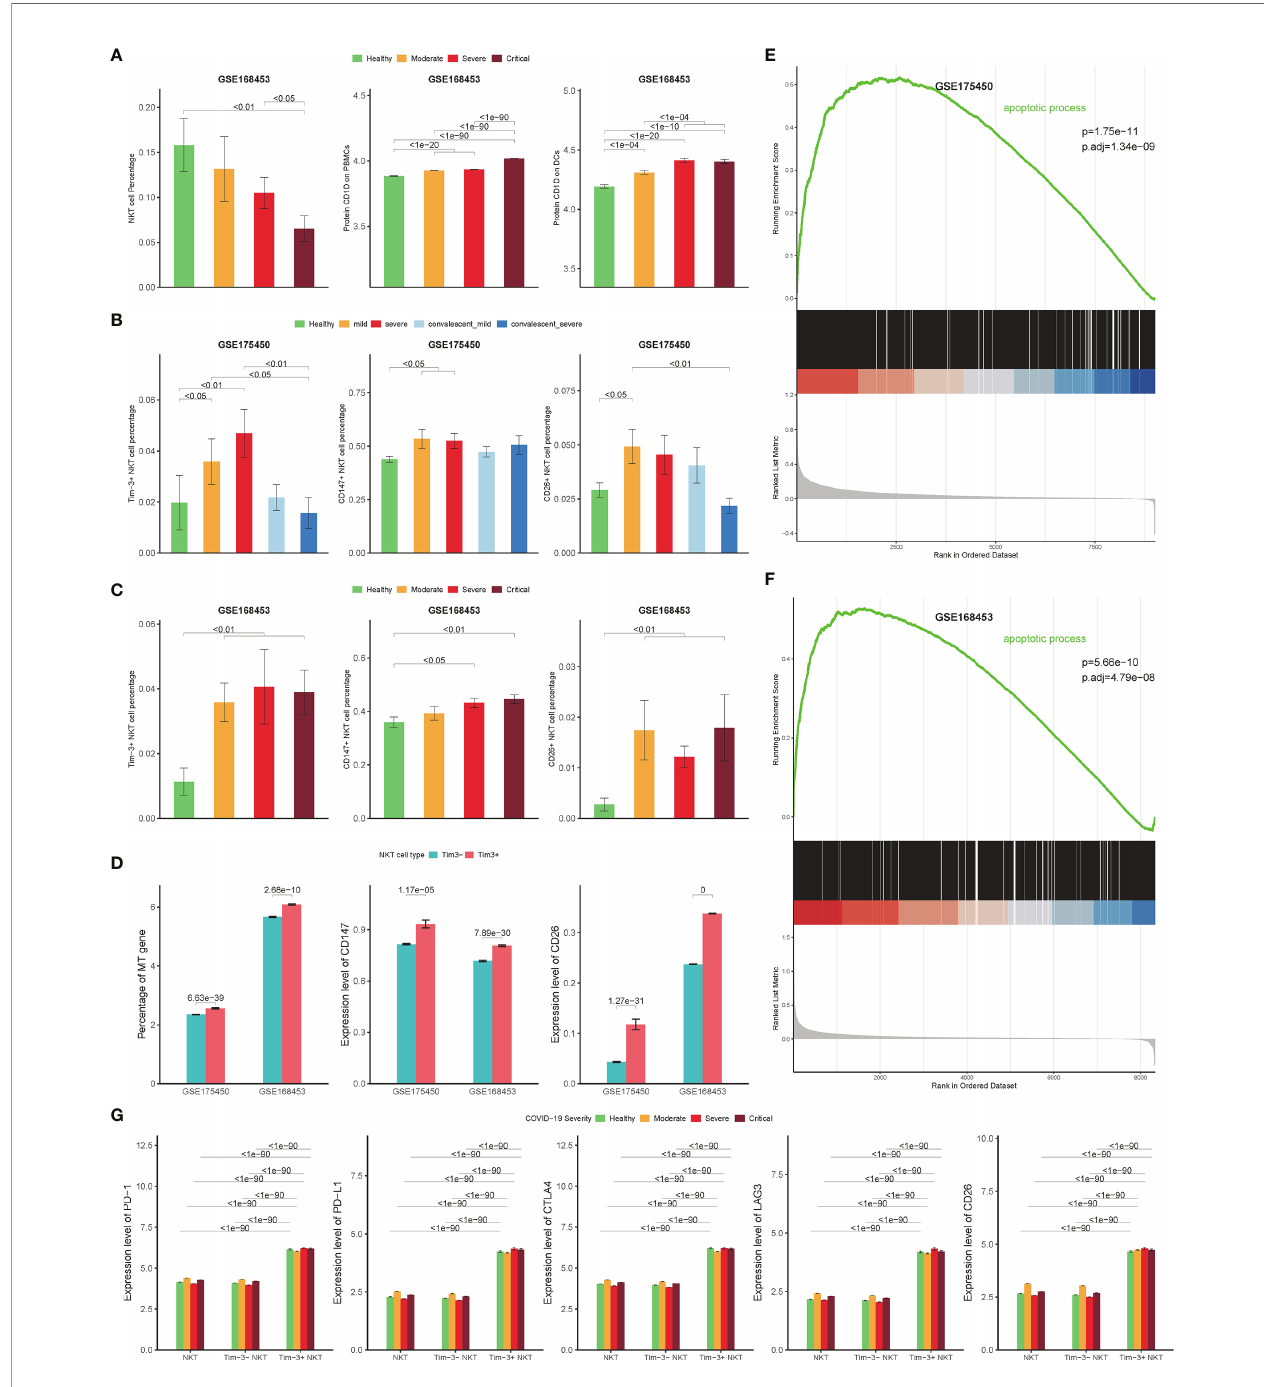
FIGURE 7 | Validation cohort results. (A) Percentage of NKT cells in COVID-19 patients and controls derived by scRNA-seq data from GSE168453 (left), protein expression levels of CD1d on PBMCs (middle) and DCs (right) derived by single-cell epitope data from GSE168453. (B, C) Percentage of Tim-3+ NKT cells, CD147+ NKT cells, and CD26+ NKT cells in COVID-19 patients and controls derived by scRNA-seq data from validation cohorts. (D) Expression of mitochondrial genes, CD147 , and CD26 in Tim-3+ NKT cells and Tim-3- NKT cells in validation cohorts. (E, F) Gene set enrichment analysis (GSEA) results of apoptotic process pathway in validation cohorts. (G) Protein expression levels of PD-1, PD-L1, CTLA4, LAG3, and CD26 on Tim-3+ NKT cells and Tim-3- NKT cells in COVID-19 patients and controls derived by single-cell epitope data from GSE168453. (Wilcoxon